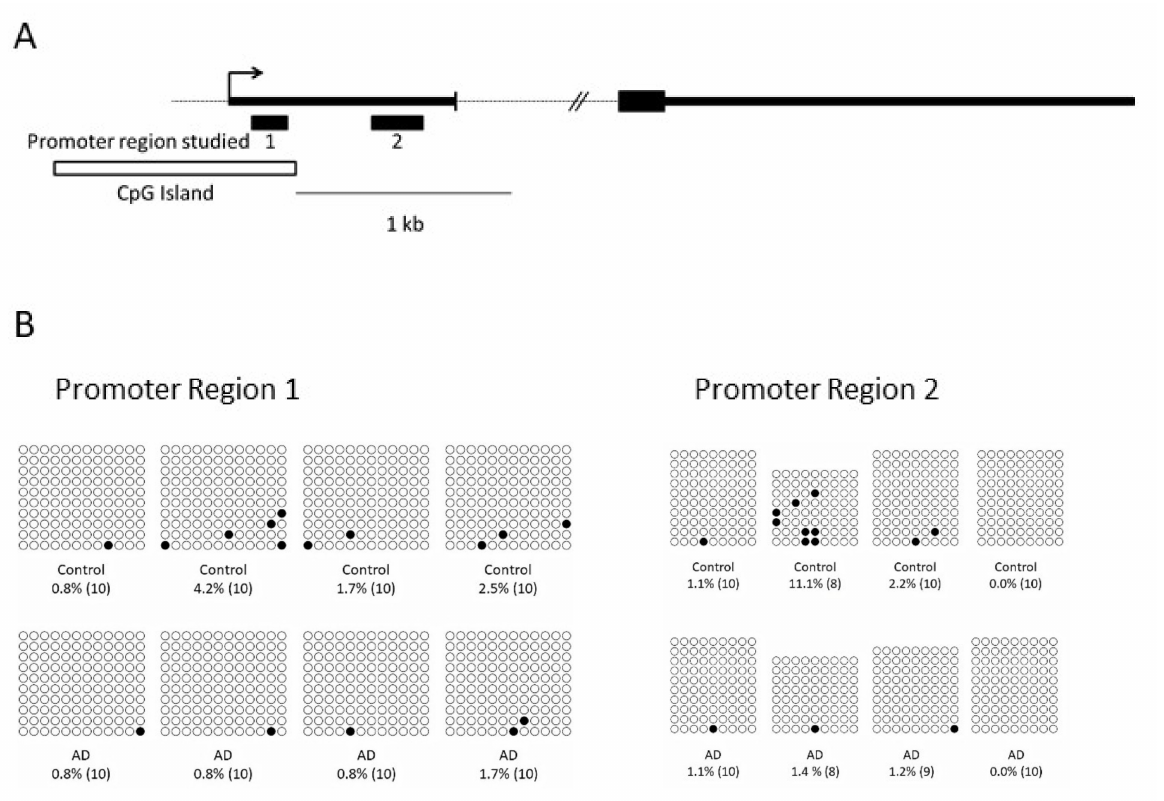
Figure 2. DNA methylation levels in entorhinal samples. ( A ) The graph shows genomic position of the amplicons (black boxes) assessed by bisulfite cloning sequencing within the exon 1 of HOMER1 gene. CpG island is represented by white box. ( B ) Bisulfite cloning sequencing for the two amplicons studied. Black and white circles denote methylated and unmethylated cytosines, respectively. Each column symbolizes a unique CpG site in the examined amplicon, and each line represents an individual DNA